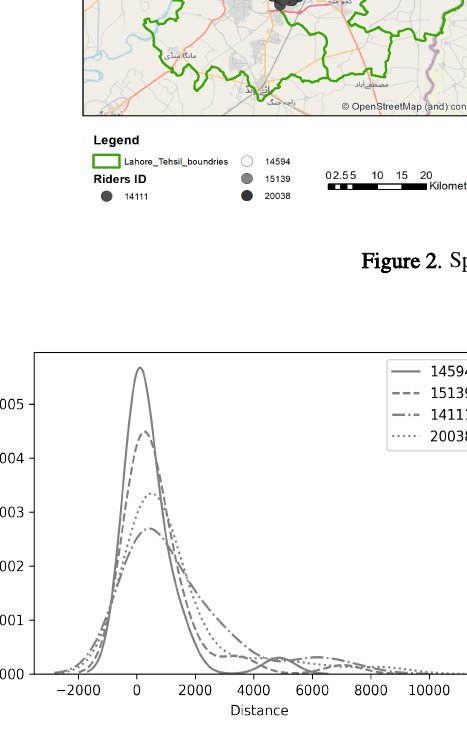
Figure 3. Kernel density estimate of deliveries (m) Figure 4. Average distance traveled by rider